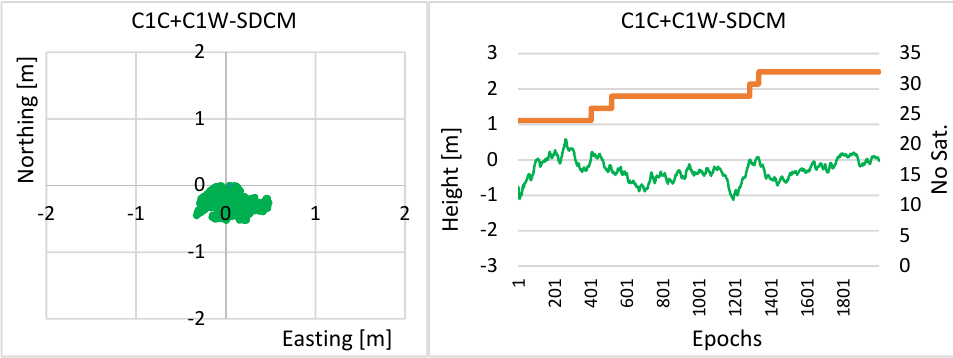
Figure 13. Real errors of coordinates of dual receiver in the constrained least squares adjustment of GPS/EGNOS positioning (Step IV, see Figure 1).